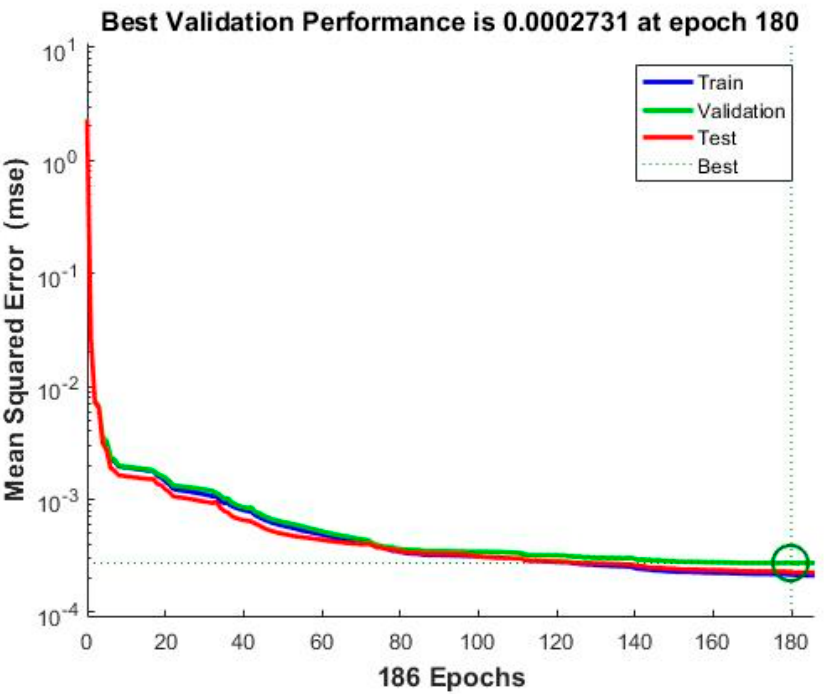
Figure 12. The trend of the MSE.